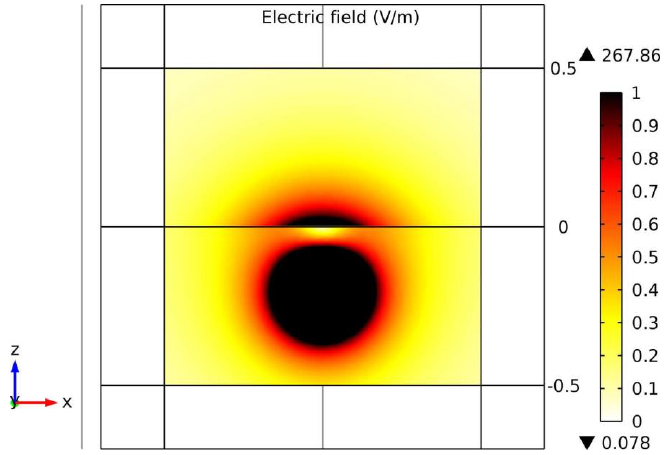
Figure 6. Numerically simulated absolute value of the electric field for a single current source I with considered values I = 1 A and ξ = (0, 0, −20 cm) T .